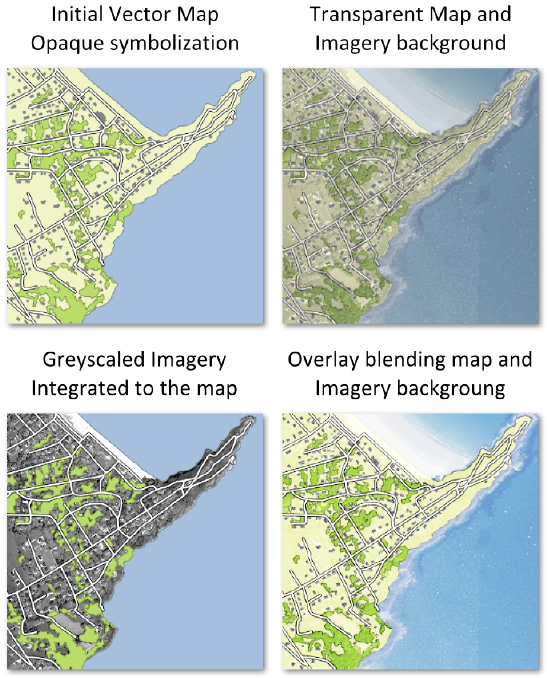
Figure 4: Natural texture extraction and reinjection